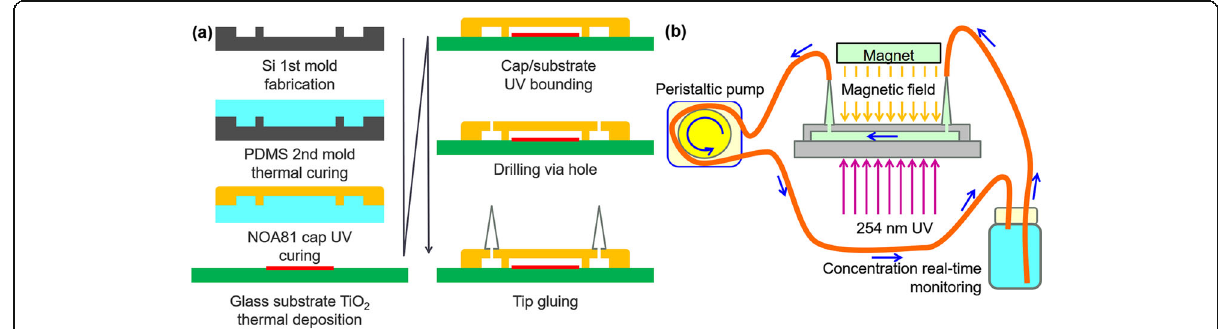
Fig. 1 Schematics of a the chip fabrication process and b the experimental